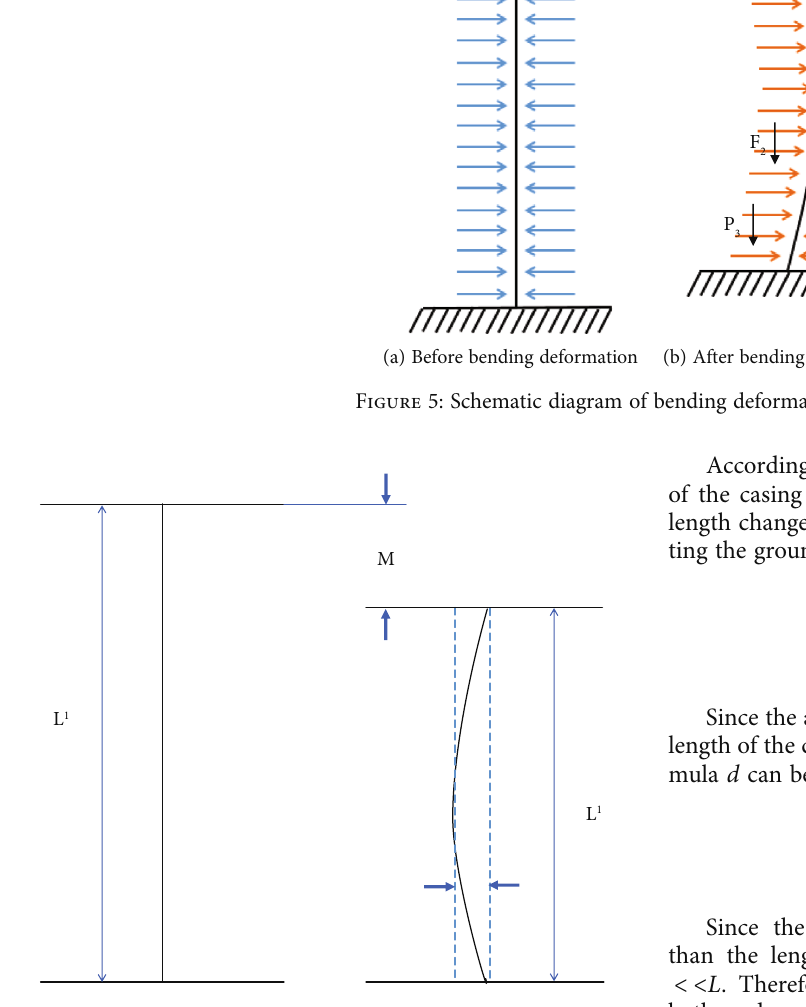
Figure 6: Diagram of the relationship between ground settlement and casing bending